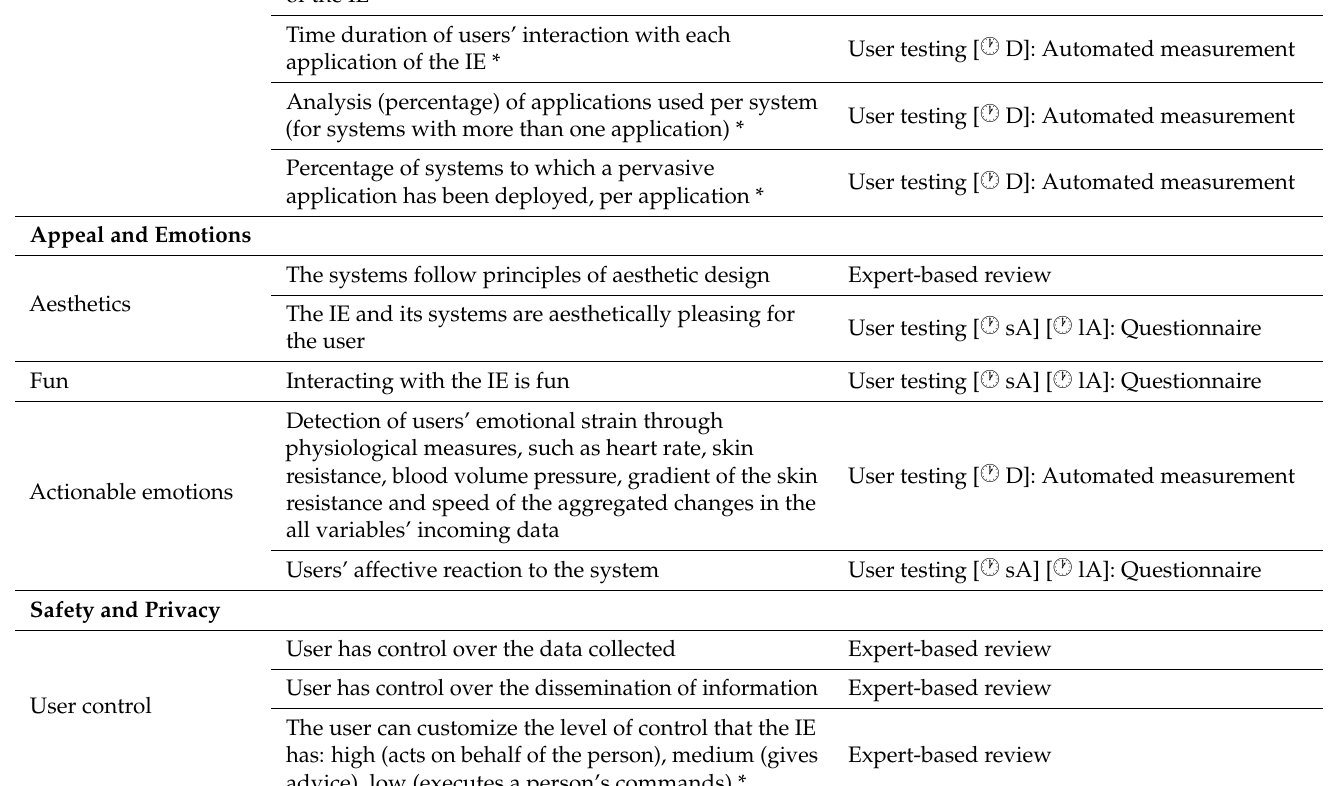
Table 1. The UXIE framework: concepts, attributes, metrics and methods. Asterisk (*) denotes metrics that are novel in the UXIE framework.